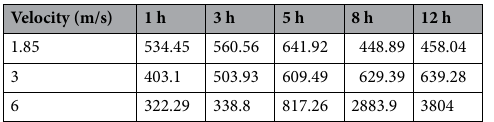
Table 4. The fitting data of polarization resistance in the HAZ.